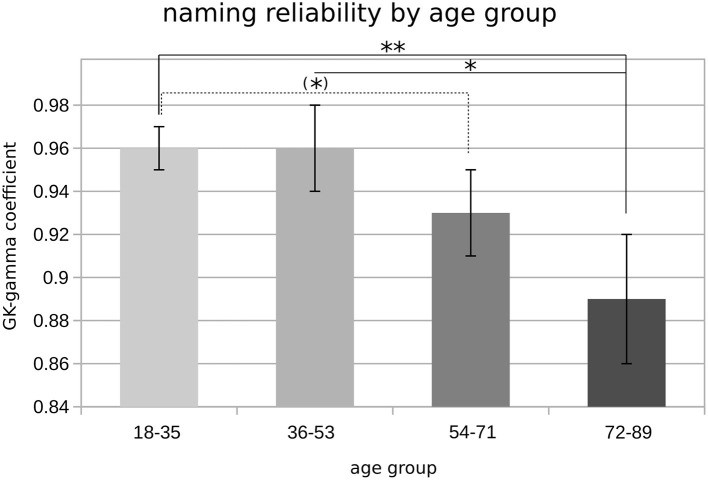
Object naming reliability by age groups. Bar plot showing mean GK-gamma coefficients (y-axis), grouped by age categories; error bars represent SEM; significance levels are indicated by asterisks [(*)p < 0.1; *p < 0.05; **p < 0.01].